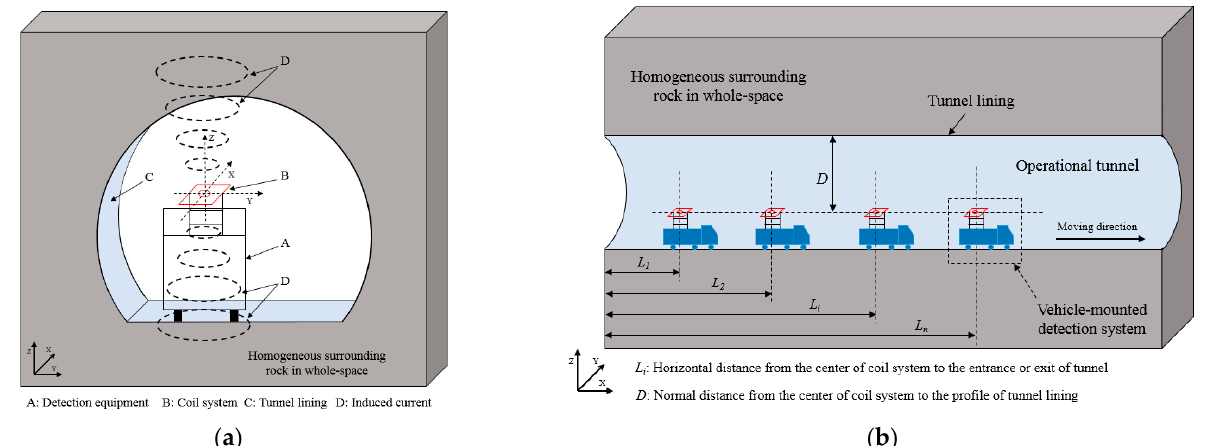
Figure 6. Principle and process of vehicle-mounted transient electromagnetic method: ( a ) basic principle; ( b ) detection process.